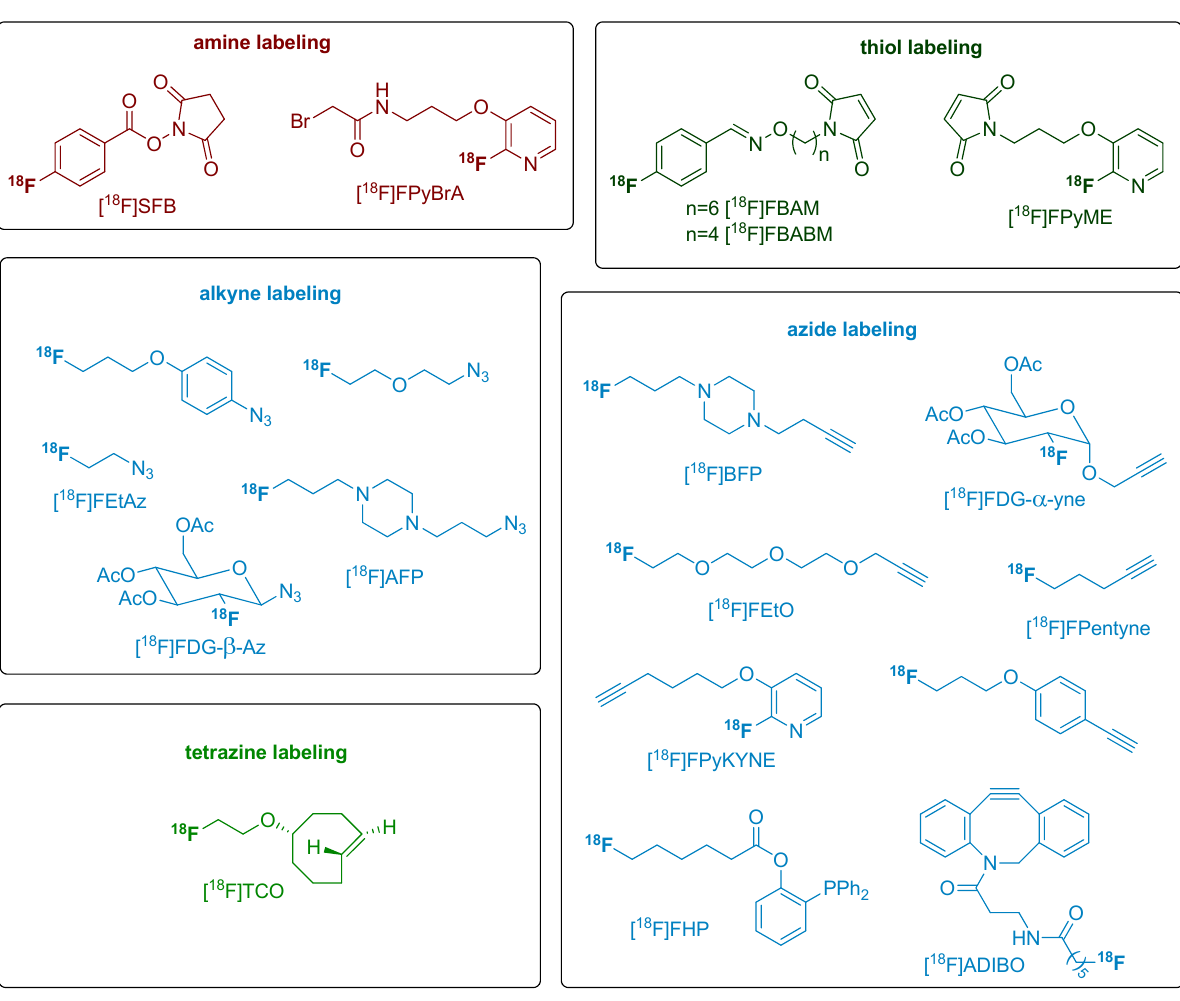
Scheme 3. A selection of various conventional and bioorthogonal labeling building blocks for the incorporation of